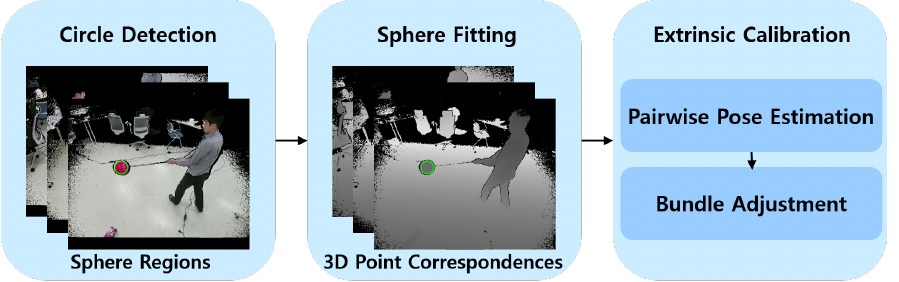
Figure 1. Proposed method for extrinsic calibration of multiple RGB-D cameras. The green circles represent detected sphere regions. Refer to the text for more